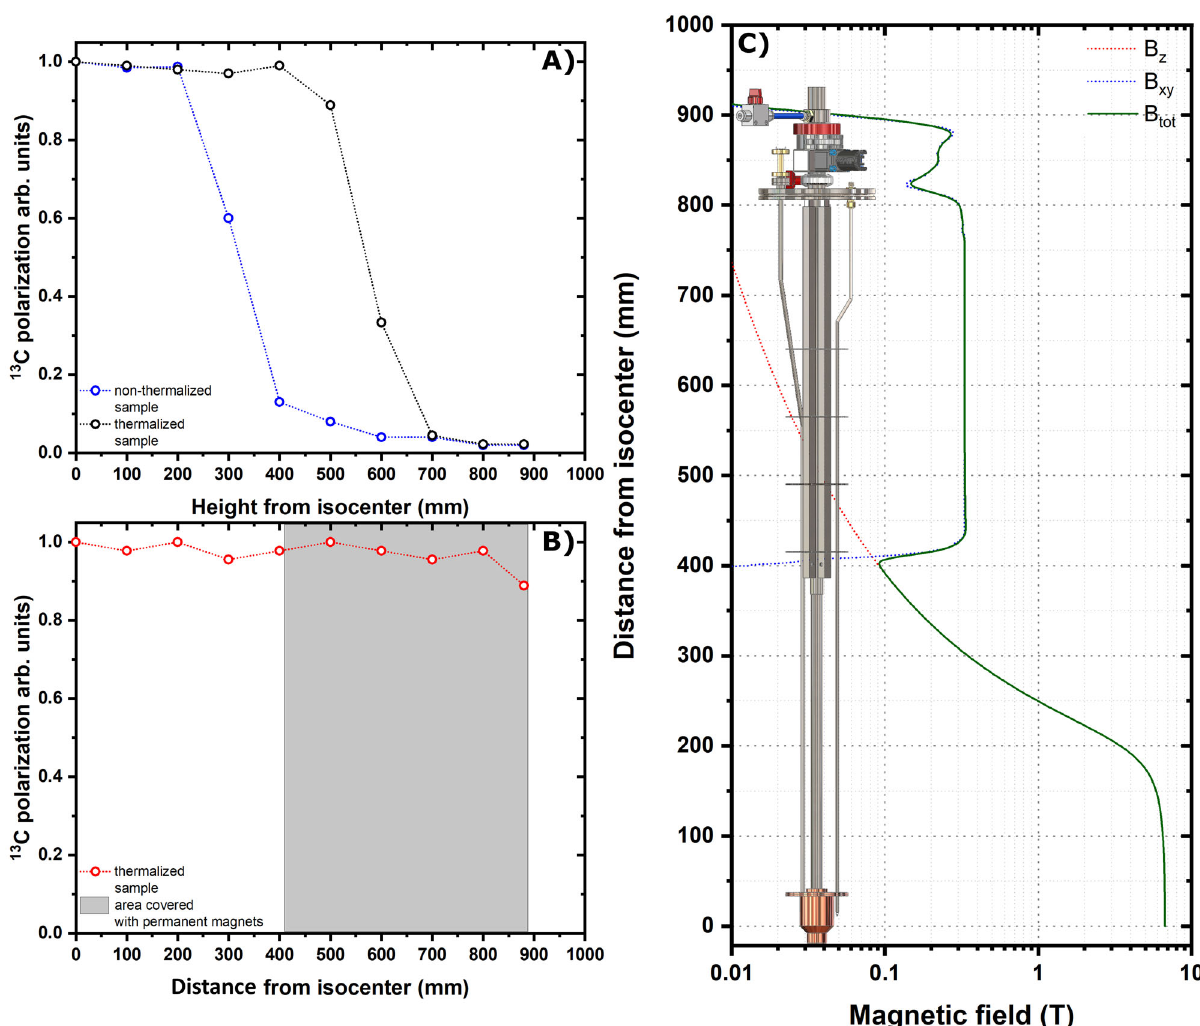
Fig. 4 Sample extraction and hyperpolarization sheltering method. 13 C polarization losses as a function of the sample vertical position inside the polarizer while using a traditional DNP probe. The experiment was repeated for a non-thermalized sample (blue circles) and a thermalized sample (black circles) ( A ). 13 C polarization losses as a function of the sample vertical position inside the polarizer while using the DNP probe equipped with permanent magnets. The experiment was performed for a thermalized sample only (red circles). The gray shaded area represents the area covered by permanent magnets in the probe. The last point was measured after lifting the sample up to the loading chamber and closing the mini-gate valve for 10 s ( B ). Calculated magnetic fi eld value as a function of the distance from the polarizer isocenter. The magnetic fi eld generated by the polarizer coil is parallel to the probe axis (red dotted line), while the magnetic fi eld generated by the permanent magnets is perpendicular to the probe axis (blue dotted line). The norm of the total fi eld is also reported (green continuous line) ( C